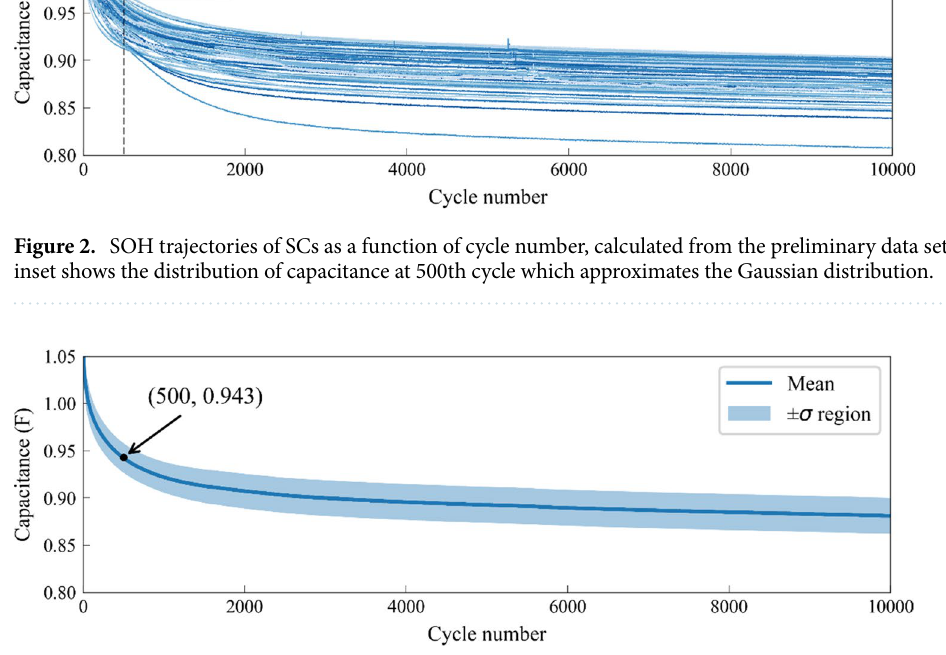
Figure 3. Mean capacitance as a function of cycle number, calculated from the preliminary data set. The black point indicates that the mean capacitance at 500th cycle is 0.943 F. The blue shaded area represents the positive and negative standard deviations of capacitance between mean-σ and mean + σ, where σ represents the capacitance dispersion degree of a given cycle, and is used to calculate the implicit covariance function in